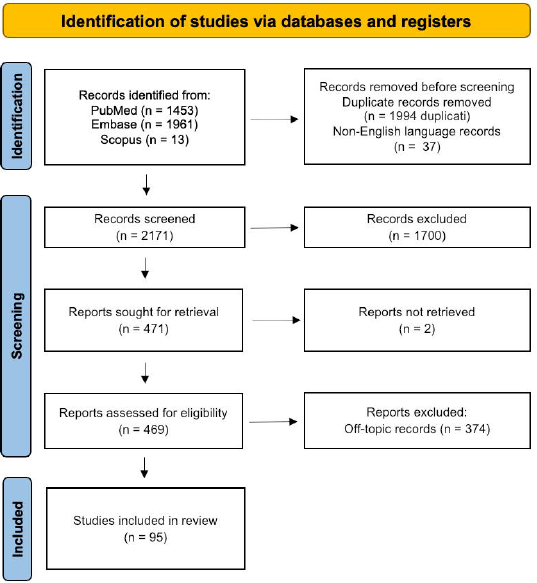
Figure 1. Preferred Reporting Items for Systematic Reviews and Meta-Analyses (PRISMA) flow chart [15].